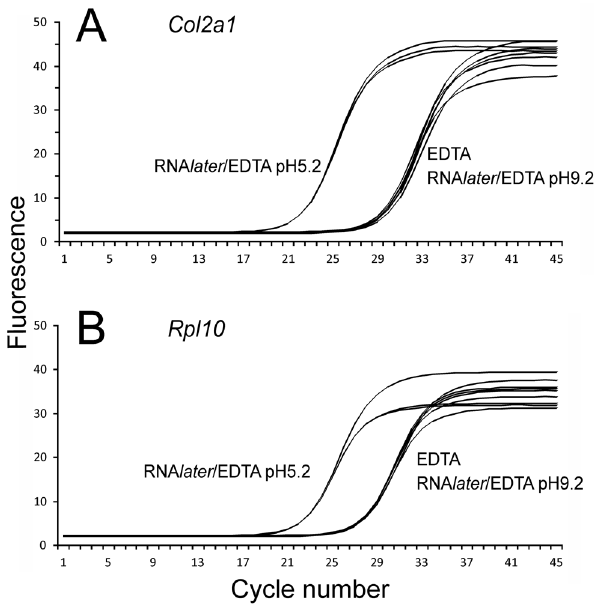
Figure 2. Quantitative PCR. Total RNA extracted from tibiae decalicified with 0.5 M EDTA, RNA later /EDTA at pH 9.2 or RNA later / EDTA at pH5.2 was analyzed for Col2a1 (A) or Rpl10 (B) mRNA transcripts by q PCR using Sybr Green. The machine output (Roche LightCycler 480 II) of fluorescence at each PCR cycle number is shown.